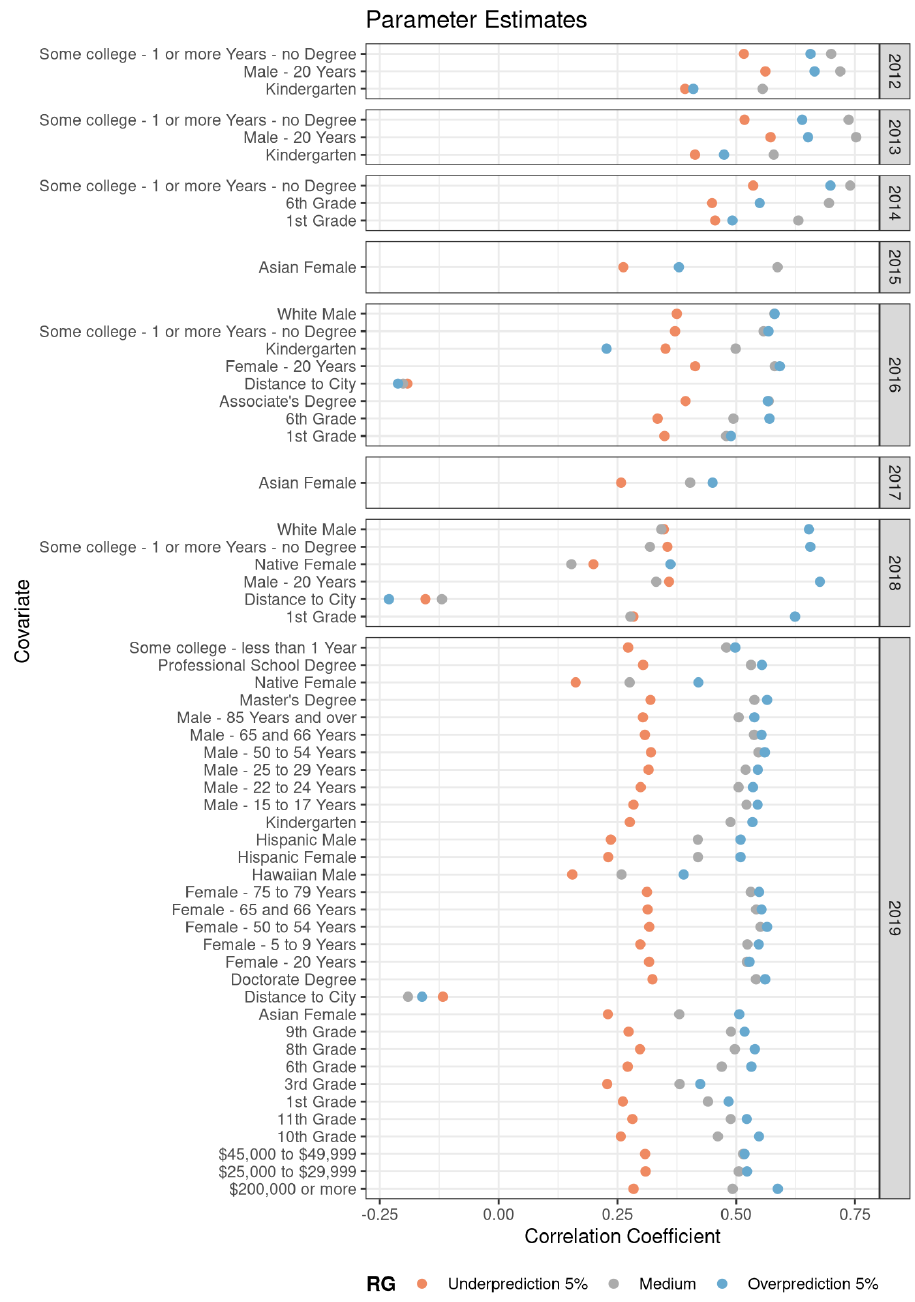
Figure 7. Correlations of grouped parameters and number of tweets, separated by RG and year. All p -values are